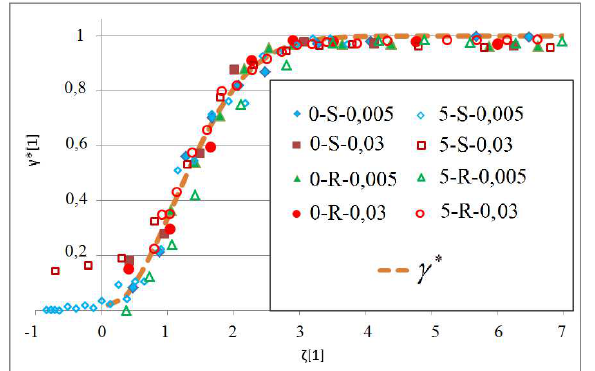
g * describes boundary .